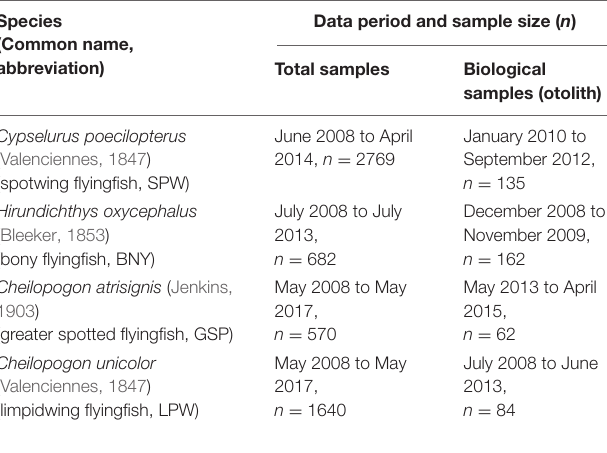
TABLE 1 | Sampling period and sample size for data and otoliths used for the study of length-weight relationship and growth parameter estimation for four flyingfish